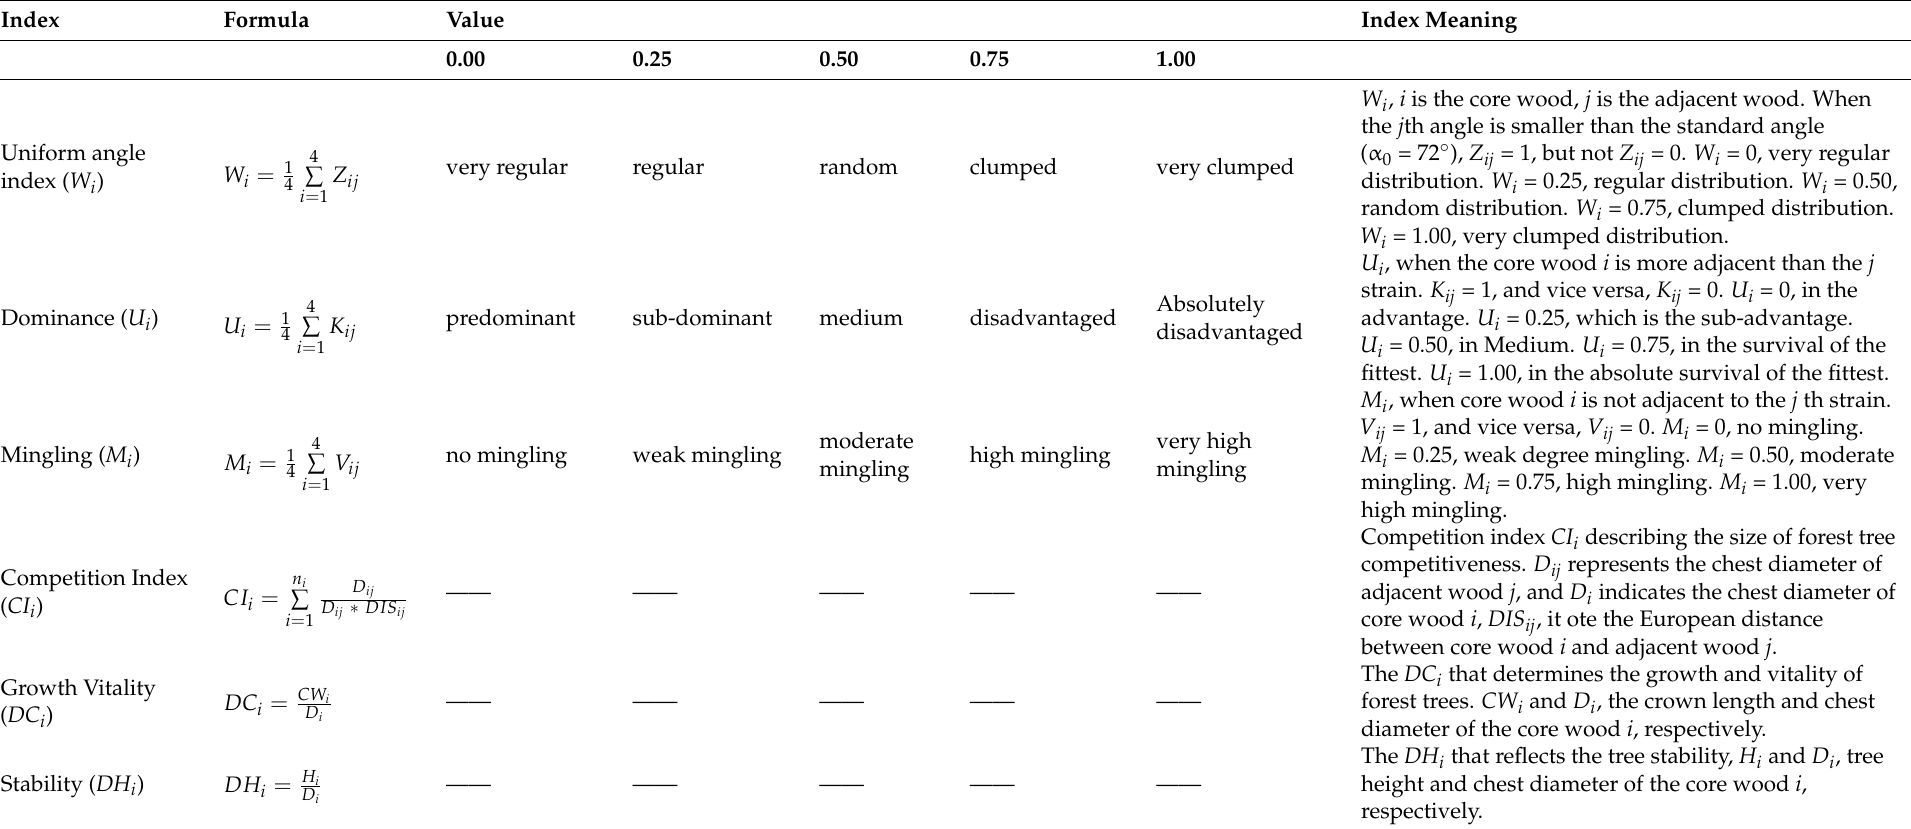
Table 4. Indicators of spatial and non-spatial structural parameters of forest stands